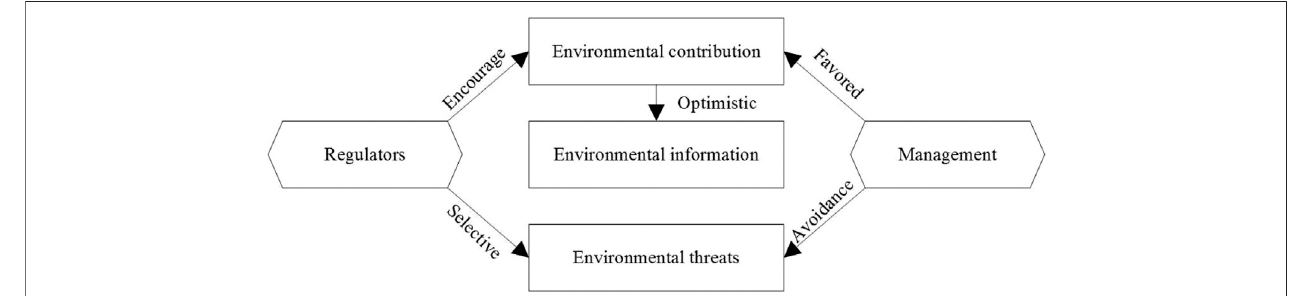
FIGURE 2 | Statistics of negative environmental information disclosure of Chinese listed companies.